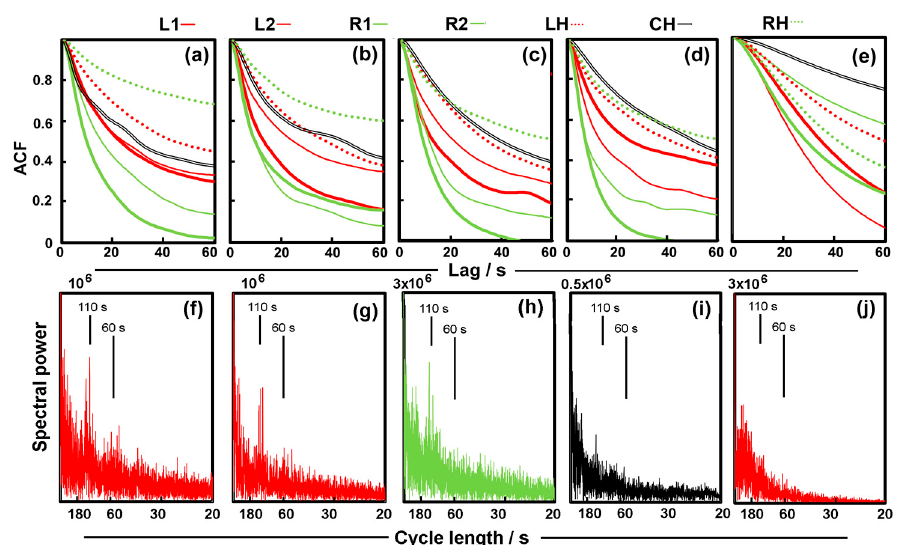
Figure 4. The autocorrelation function (ACF) of 1-s NOx concentrations for the seven nodes for the four days: ( a ) 12–21, ( b ) 12–22, ( c ) 12–28 and ( d ) 12–29. ( e ) Average autocorrelation of 1-s CO across the four nodes for the entire campaign. Fourier transforms for NOx on 12–21 at the kerbside nodes, ( f ) L1, ( g ) L2 and ( h ) R2, and the elevated node on the overhead walkway ( i ) CH, along with the transform for ( j ) kerbside CO at L1. Note the spectral power takes the units ppb 2 Hz − 1 , with the quantity at the top of each figure ( f – j ) shown by the small numerals.